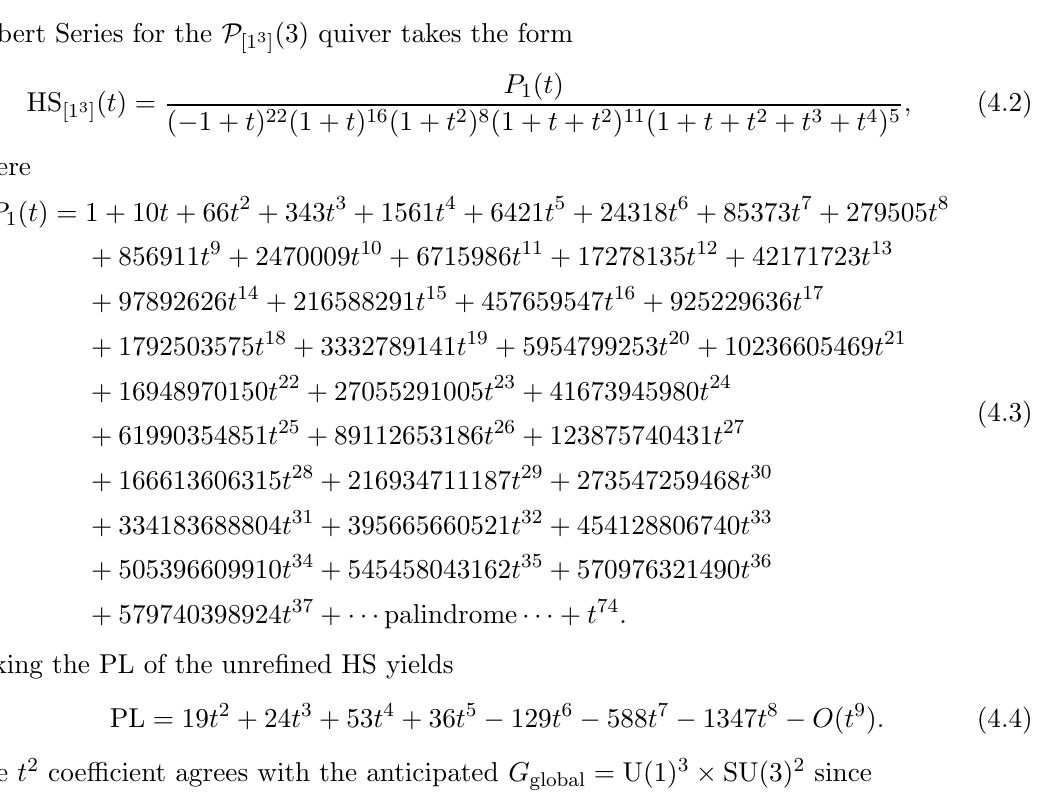
Figure 29 . P (3) quiver with SU(3) 2 (cid:2) U(1) 3 global symmetry, b i = 1 ; i = 1 ; 2 ; 3 ; 4, [1 3 ] dim M H = C